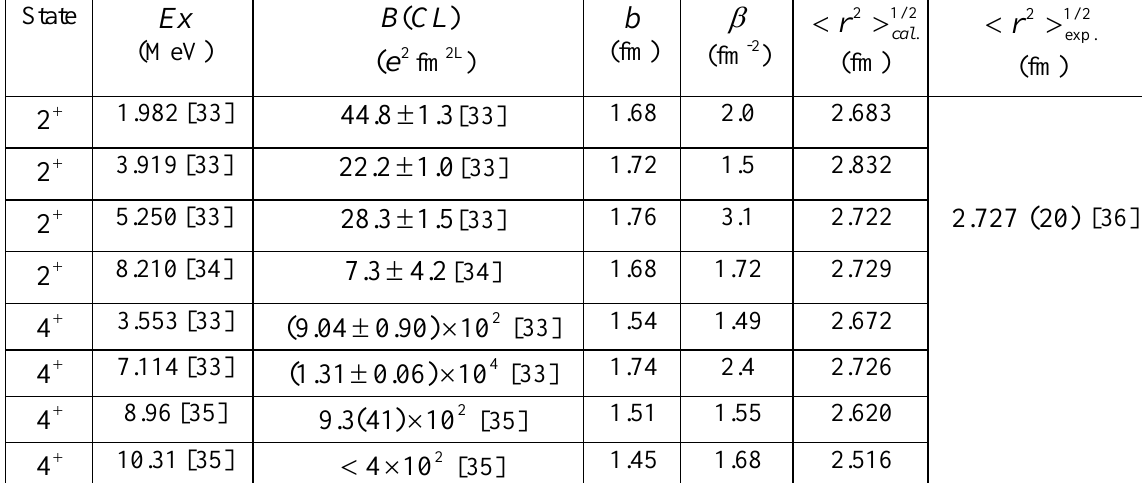
Table 1: The experimental excitation energies and reduced transition probabilities, the chosen values for b and β as well as the rms charge radius calculated with the effect of the SRC of 18